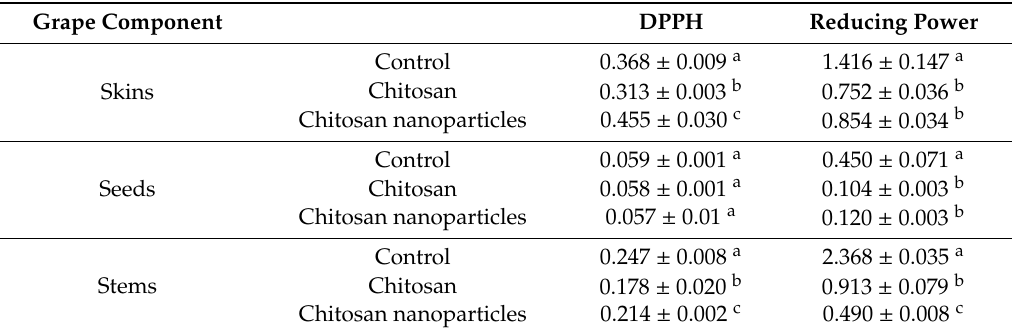
Table 3. Antioxidant activity of the skins, seeds and stems of Sous ã o variety with no treatment (control), treated with chitosan and with chitosan nanoparticles expressed in EC 50 (mg / mL) (mean value ± SD, n =